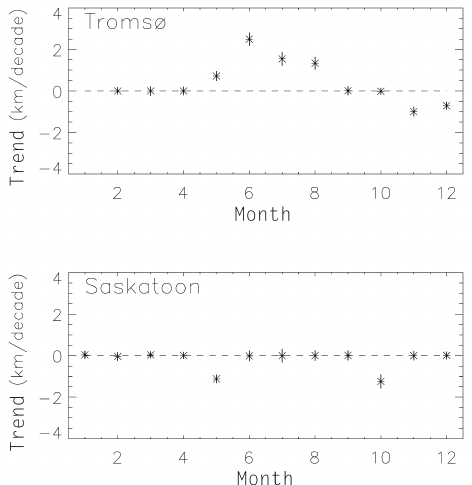
Figure 2. Trends for the period as a function of month. Upper panel: 70 ◦ N (Tromsø); lower panel: 52 ◦ N (Saskatoon).